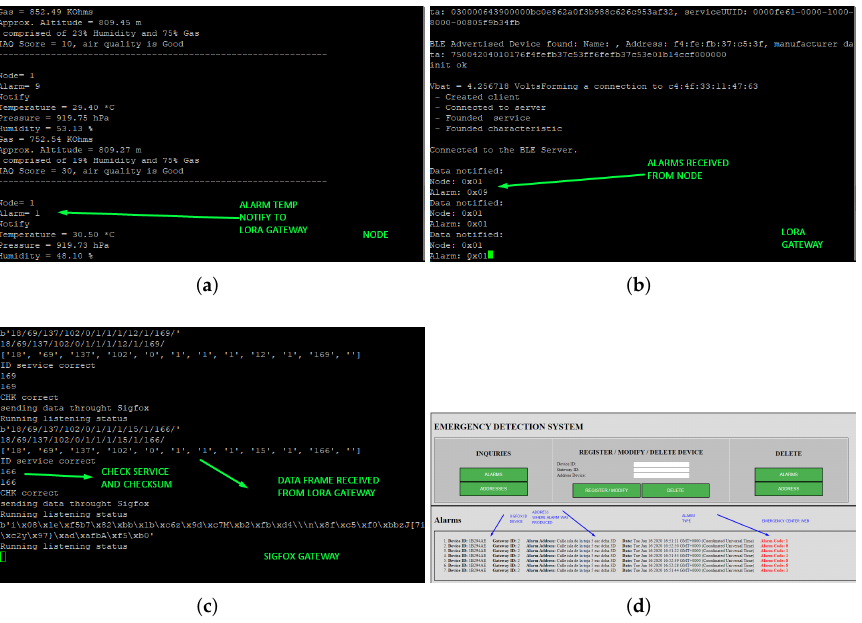
Figure 8. Process of the firmware working on diverse devices of the system. ( a ) Node/sensor idle status. ( b ) LoRa gateway receiving an alarm from the BLE subnet. ( c ) Sigfox gateway receiving a dataframe through LoRa RAW. ( d ) Emergency center/client